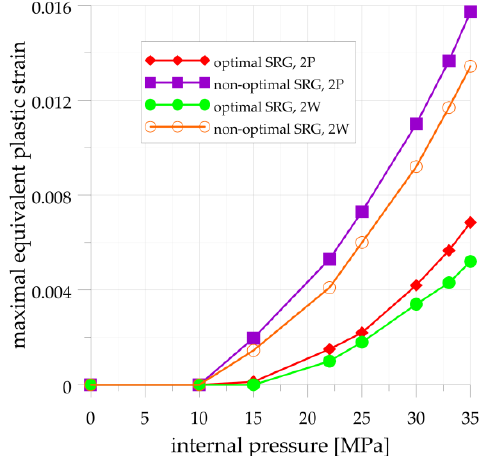
Figure 18. Maximal equivalent plastic strain in optimal and non-optimal SRG.